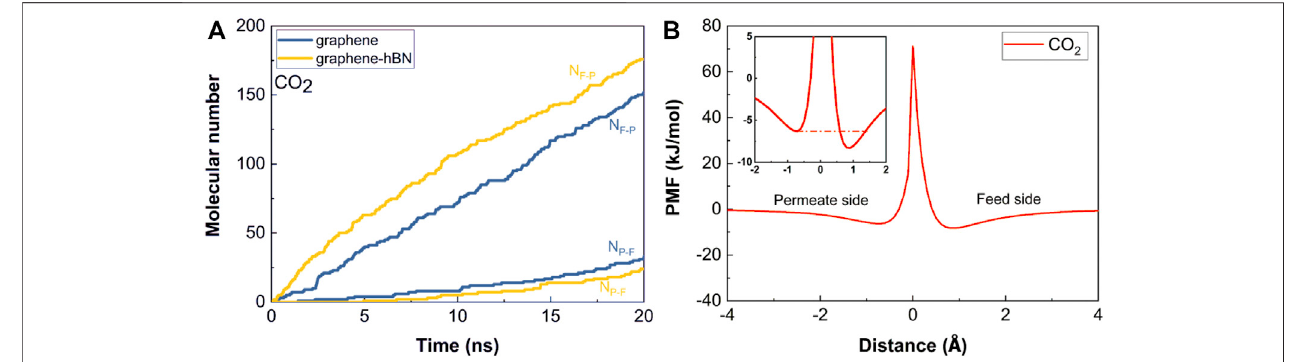
FIGURE 4 | Quasi-unidirectional gas transport. (A) Time variations of the number of molecular crossings in two directions for the separation of CO 2 /CH 4 ; (B) PMF pro fi les of CO 2 molecules passing through the bilayer nanopore.